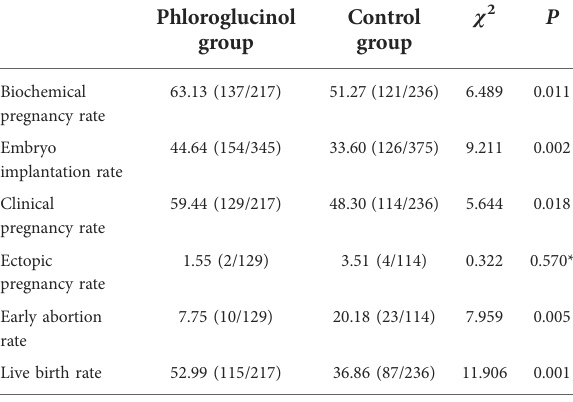
TABLE 2 Comparison between two groups in terms of pregnancy outcomes